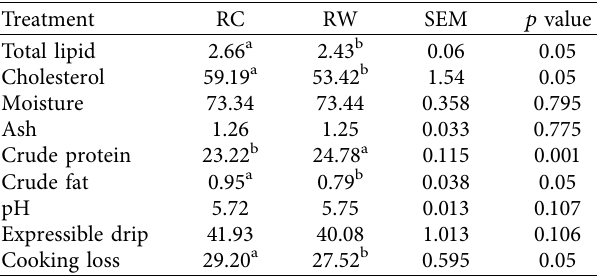
Table 2: Total lipid content (%), cholesterol content (mg/100 g), proximate analysis (%), pH, expressible drip (%), and cooking loss (%) of raw pork